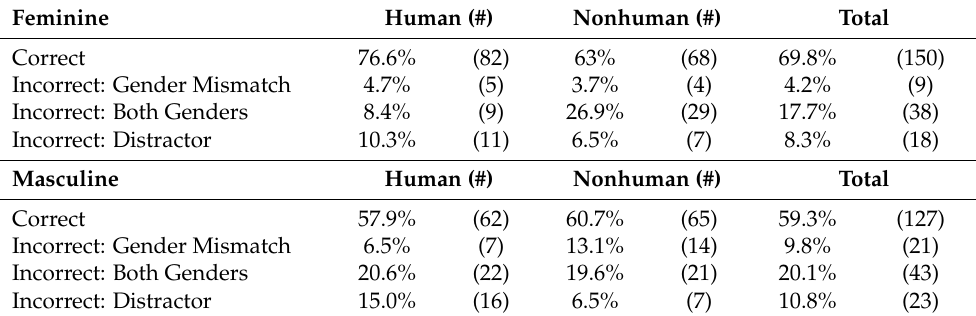
Table 4. Picture selection task results by gender and the [ ± Human] feature, L2 group.